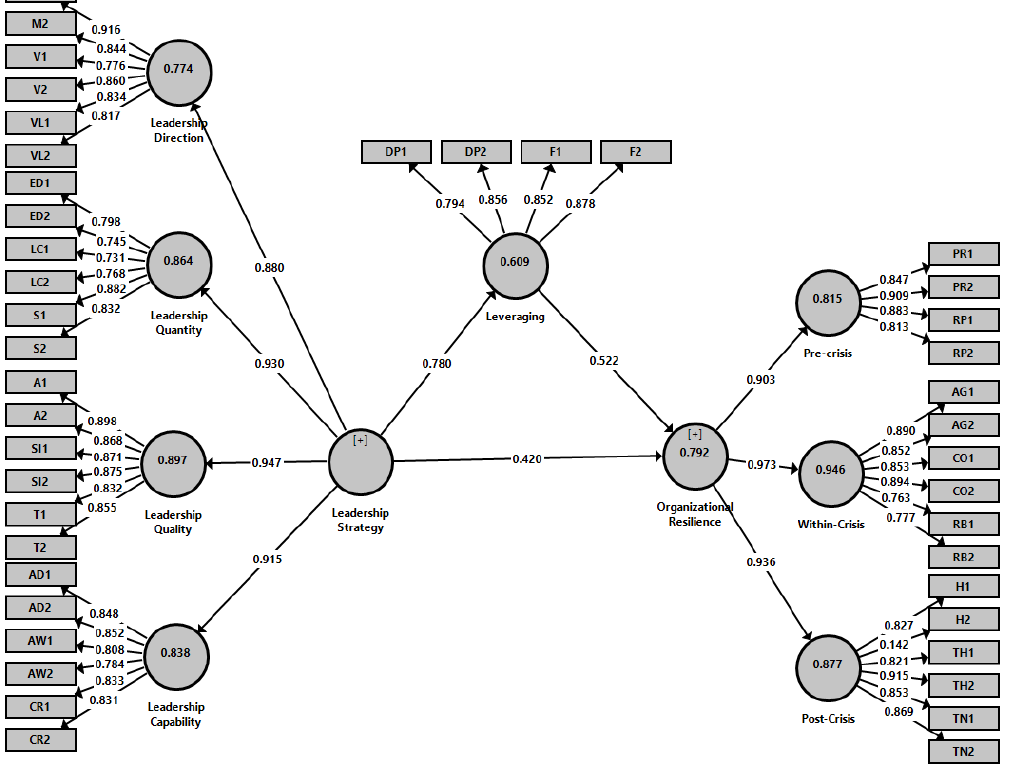
Figure 8: Model Path Coefficients of Resource Leveraging